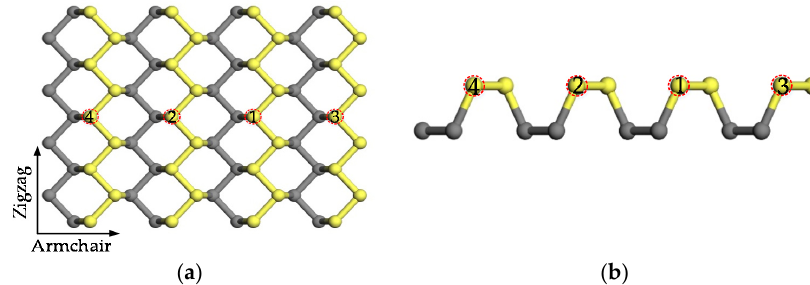
Figure 1. The different views of physical model: ( a ) top view and ( b ) side view. Atoms in the top and bottom layers are in yellow and grey, respectively. The positions of impurity atoms are marked by red circles.